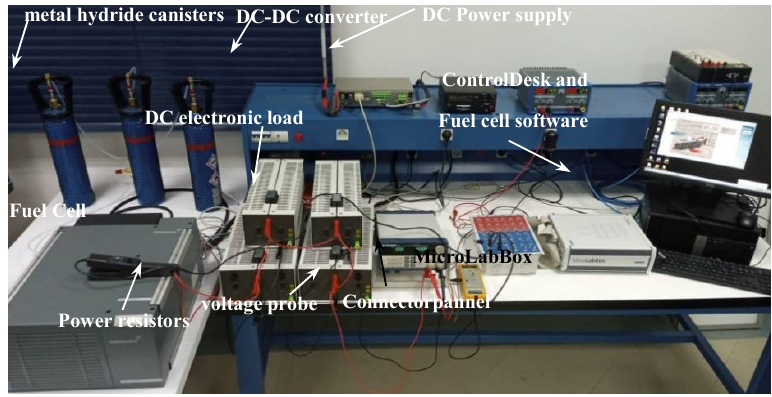
Figure 7. View of the experimental bench.